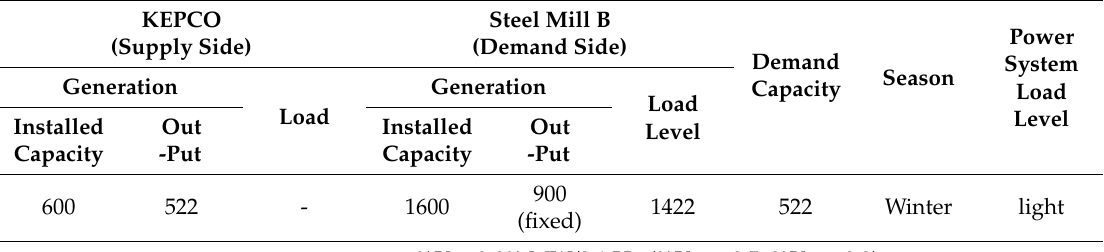
Table 10. Simulation data for steel mill B (winter, light load).